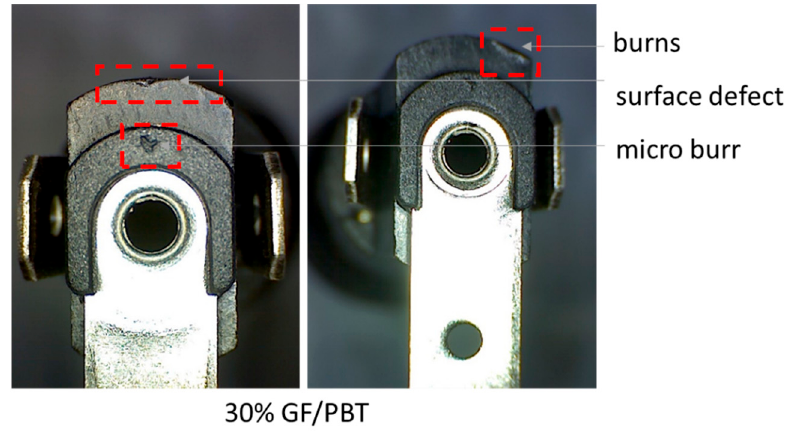
Figure 15. Optical image of micro-faults on 30% GF/PBT composite.